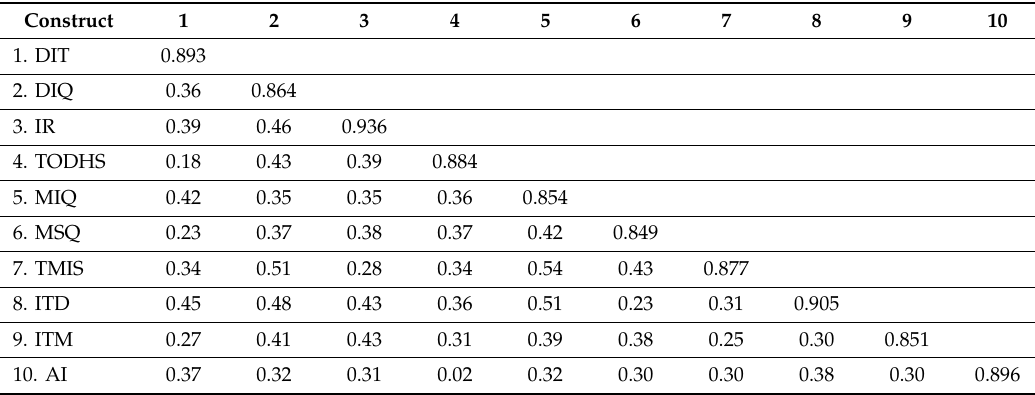
Table 4. Latent variable correlation matrix: Discriminant